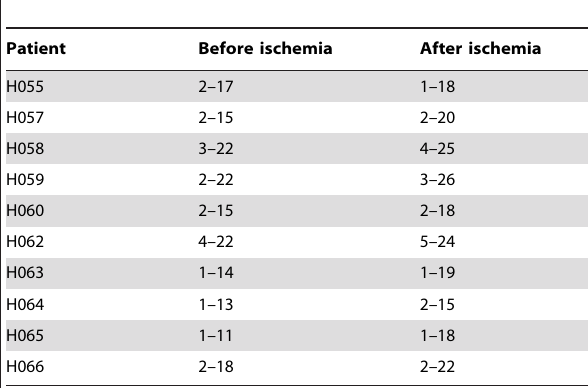
Table 3. Minimal and maximal values of the number of phase singularities during the first and the last ten seconds of ischemia for the patients studied in